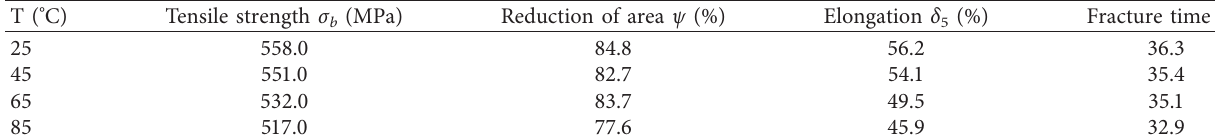
Figure 7: SEM images of fracture surface morphology of tensile test coupons (Pco � 0.1MPa, Cl − � 60,000mg/L): (a) T � 65 ° C; (b) T � 85 ° C. 2 Table 6: Main mechanical properties of 316L stainless steel at different temperatures.